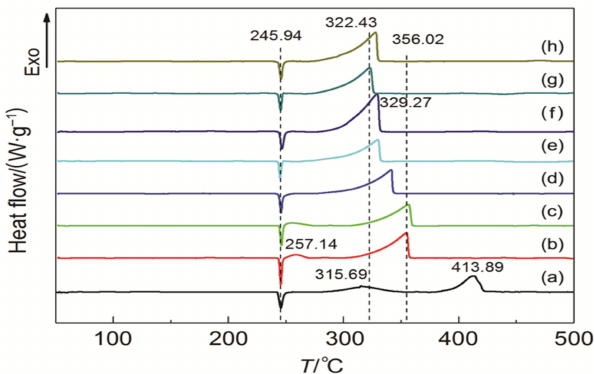
Figure 13. DSC curves of the AP decomposition in the absence and presence of different blend ratios of nanoporous CoFe 2 O 4 . Reproduced with the permission of ref. [73]. Copyright 2016, Acta Physico- Chimica Sinica. ( a ) pure AP; ( b ) AP + nanoporous CoFe 2 O 4 -1% ( ω ); ( c ) AP + nanoporous CoFe 2 O 4 - 2%; ( d ) AP + nanoporous CoFe 2 O 4 -3%; ( e ) AP + nanoporous CoFe 2 O 4 -4%; ( f ) AP + nanoporous